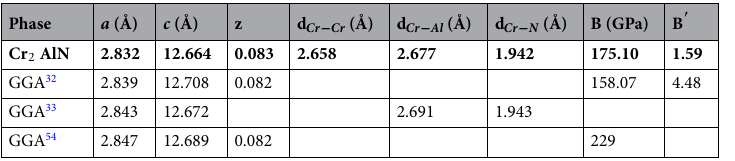
Table 4. Structural properties of the hexagonal Cr 2 AlN for this work in bold. Other theoretical results are also included for comparison.